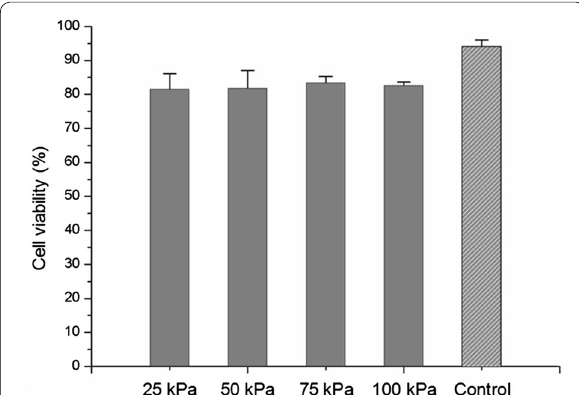
Fig. 5 Cell viability result for various positive pressures. The graph shows a slight loss of cell viability after cell